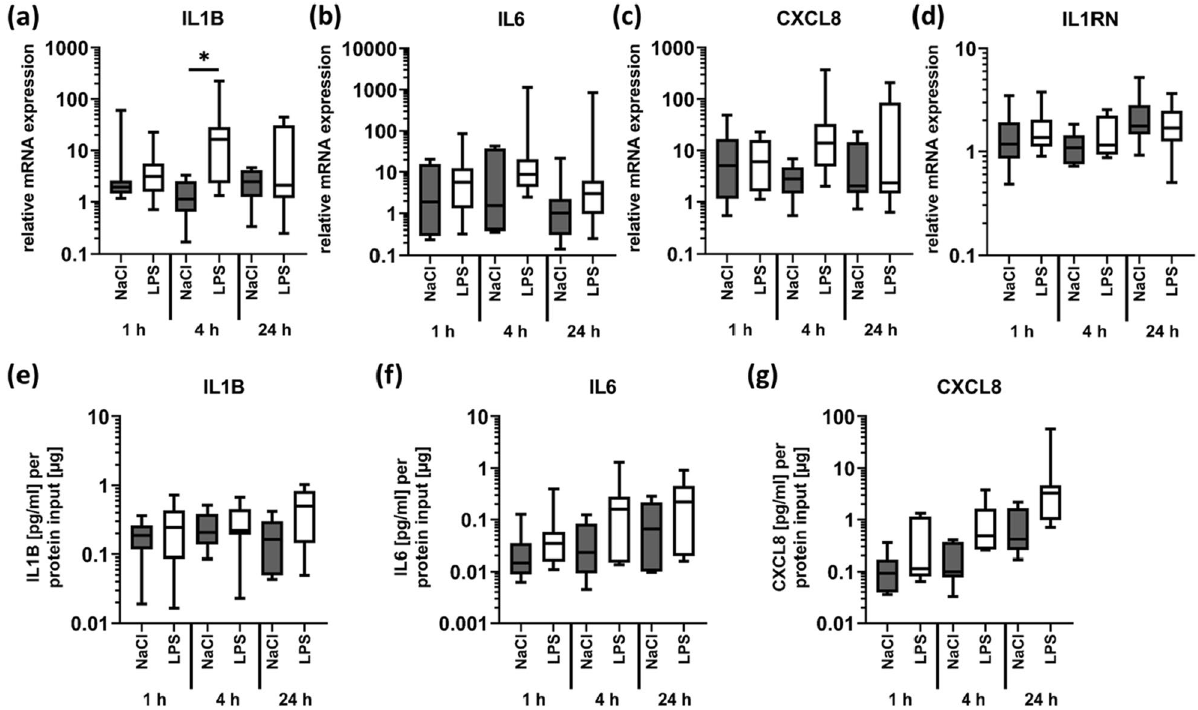
Figure 6. Stimulation with LPS enhances production of pro-inflammatory mediators. LPS (1 µg/ml in 0.9% NaCl; 450 µl/cm 2 ) was injected into the dermis of fresh skin explants to analyse inflammatory processes. NaCl was used as a control for the injection trauma. Biopsies were collected after 1, 4 and 24 h. Relative mRNA expression levels of ( a ) IL1B (n = 8), ( b ) IL6 (n = 7), ( c ) CXCL8 (n = 7) and ( d ) IL1RN (n = 8) were determined by RT-qPCR, normalizing target gene expression to the averaged expression of RPLP0 and TBP. Local cytokine concentrations were measured in homogenized biopsies using the V-PLEX Proinflammatory Panel 1 Human Kit (MSD). Out of 10 candidate analytes, only ( e ) IL1B (n = 6), ( f ) IL6 (n = 6) and ( g ) CXCL8 (n = 6) could be quantified. Data are presented as median (line) the interquartile range (box) and the minimum and maximum values (whiskers) from 6–8 individual skin explants. P-values < 0.05 were considered as statistically significant with *, **, *** indicating p < 0.05, p < 0.01, and p < 0.001, respectively (dependent on normal distribution ANOVA or Kruskal–Wallis